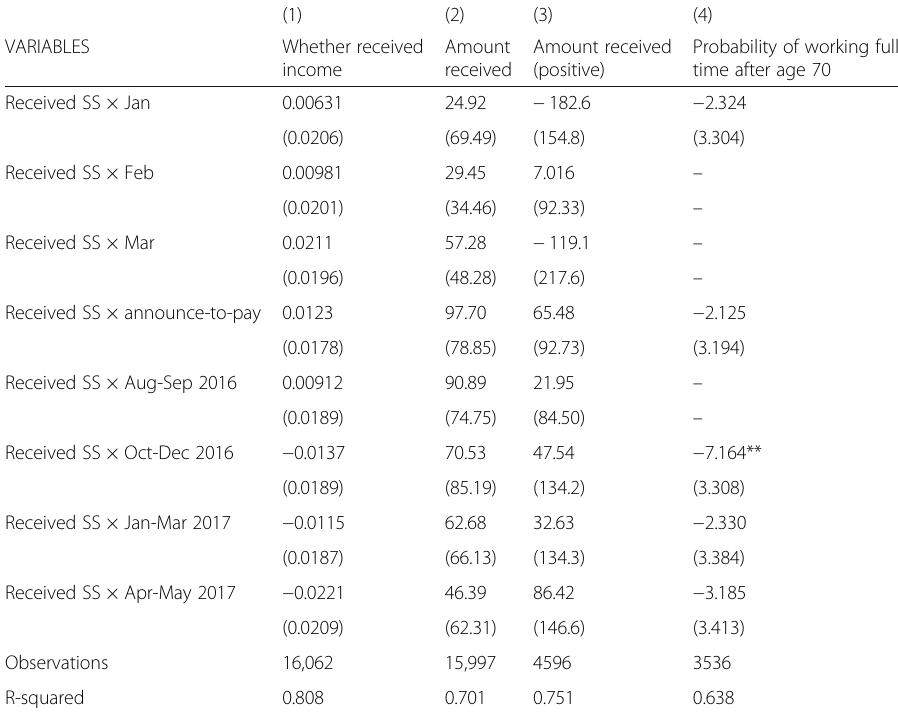
Table 3 Temporal impact of receiving SSS payouts on labour decisions